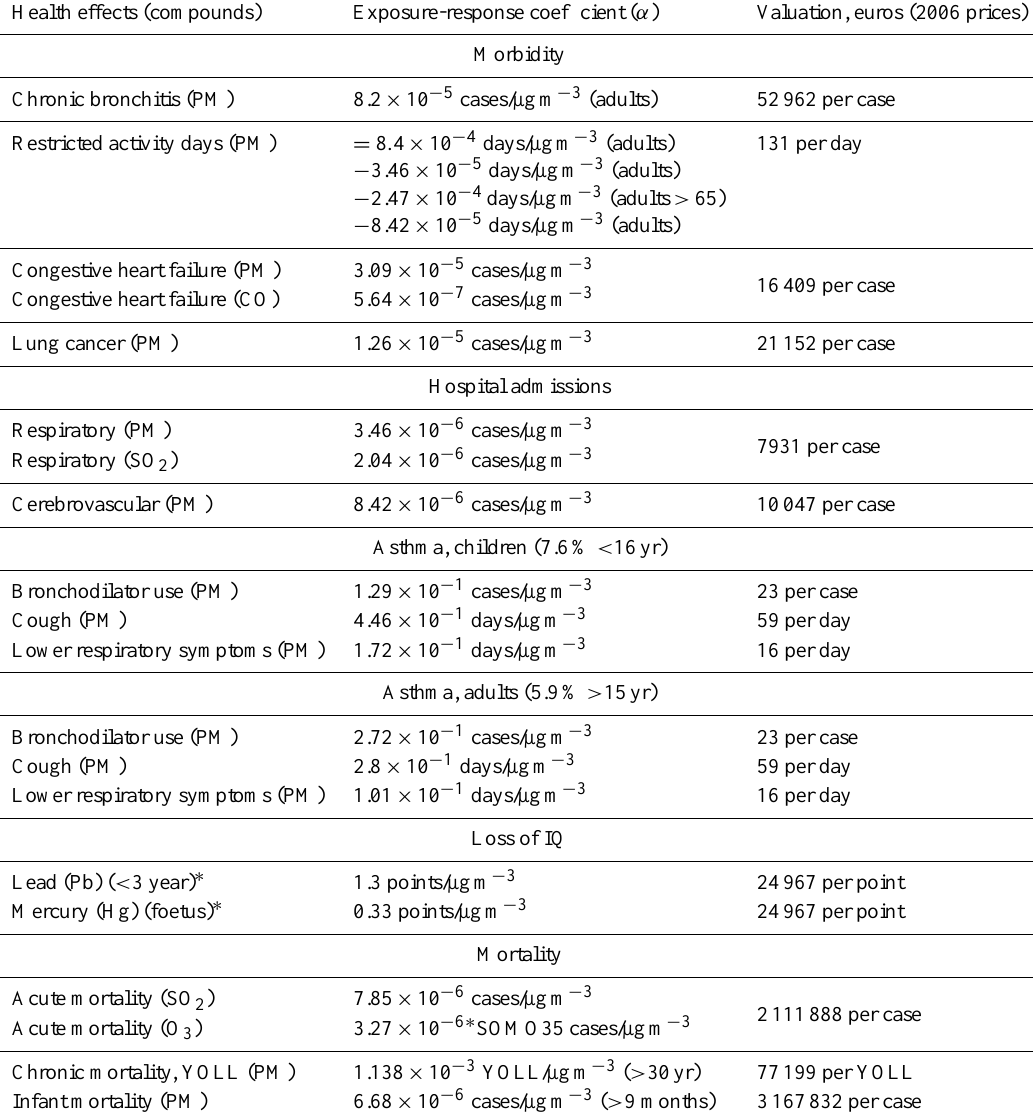
Table 1. Health effects, exposure-response functions and economic valuation (applicable for Danish/European conditions) currently included in the EVA model system. (PM is particulate matter, including primary PM 2 . 5 , NO − of O zone M eans O ver 35ppb) is the sum of means over 35ppb for the daily maximum 8-hour values of